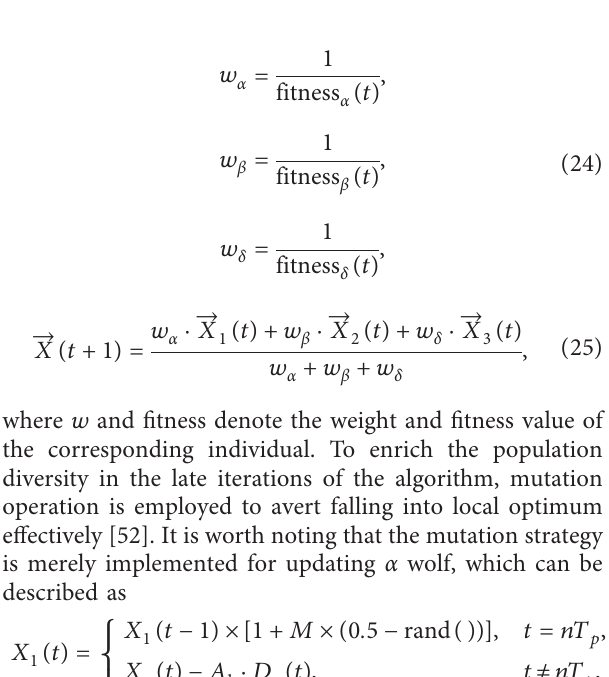
Figure 2: Convergence curves of a ⇀ over the course of iterations obtained by the employed function and the original